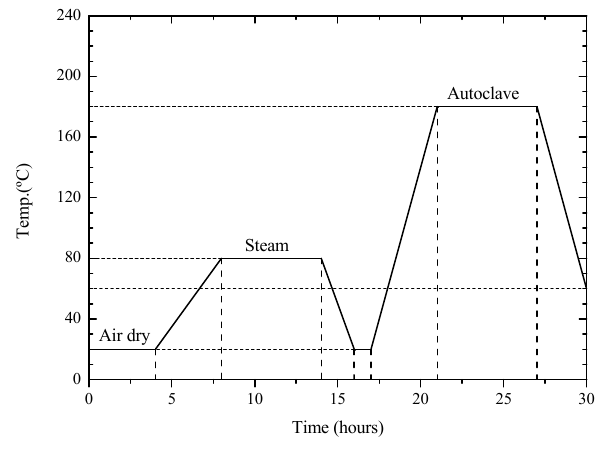
Figure 6. Curing process.